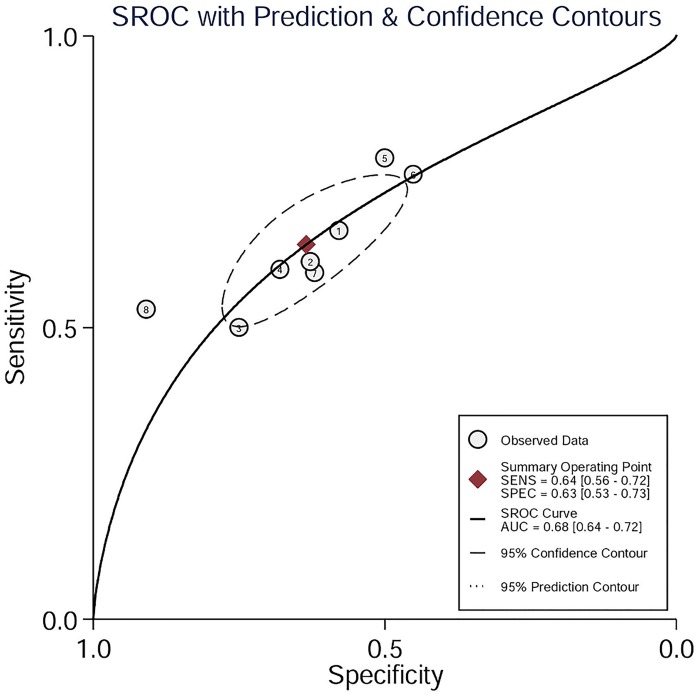
Hierarchical summary receiver operating characteristic plot of serum LBP level across all included studies.1: Axel Nierhaus 2013 [11]; 2: Y.Sakr 2008 [7]; 3: M.Prucha 2003 [9]; 4: M.Tromp 2012 [13]; 5: S.Gaini 2007 [15]; 6: P.Gille-Johnson 2012 [14]; 7: Franz Ratzingerl 2013 [12]; 8: Iwan A.Meynaar 2011 [16]